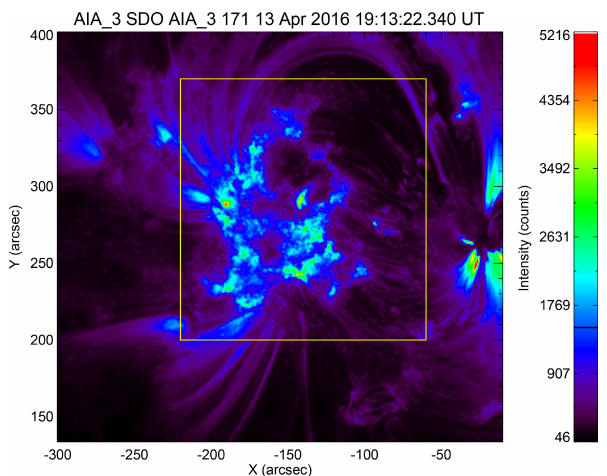
Figure 1. Intensity emission due to 171Å wavelength of SDO–AIA at 19:13:22UT. The yellow box is overlaid to show the region of in- terest (ROI) taken to analyze the flows at the foot points of quiescent coronal